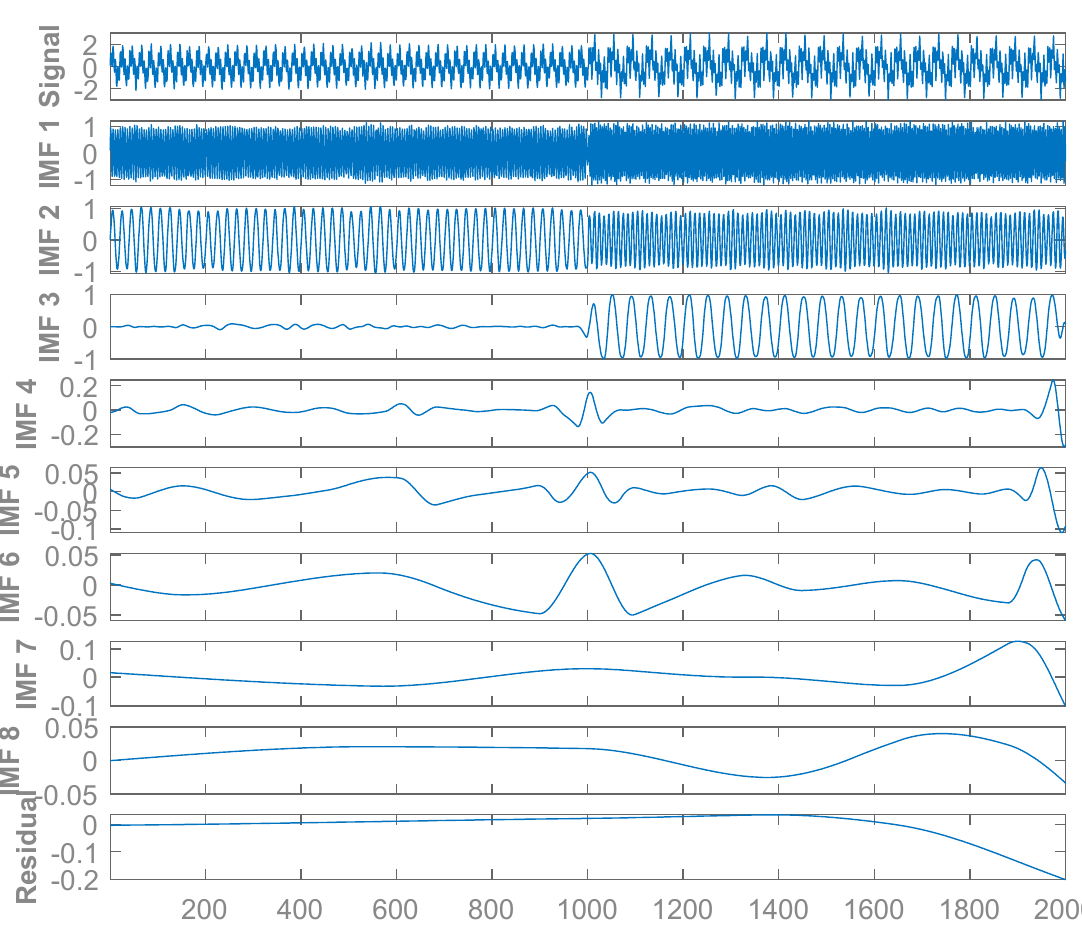
Figure 4. Decomposition by EEMD illustrating 8 out of 8 intrinsic mode functions (IMFs).